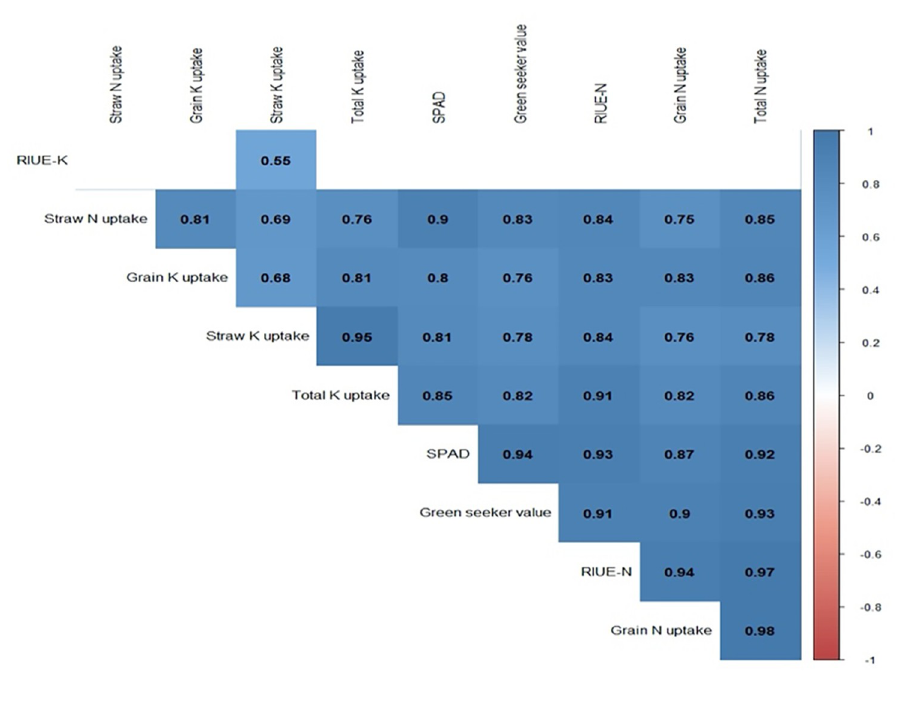
Fig 9. Correlation matrix depicting relationships between different variables and wheat grain yield (r > 0.435; significant at p < 0.05 and r > 0.802 significant at p < 0.01, others non-significant).